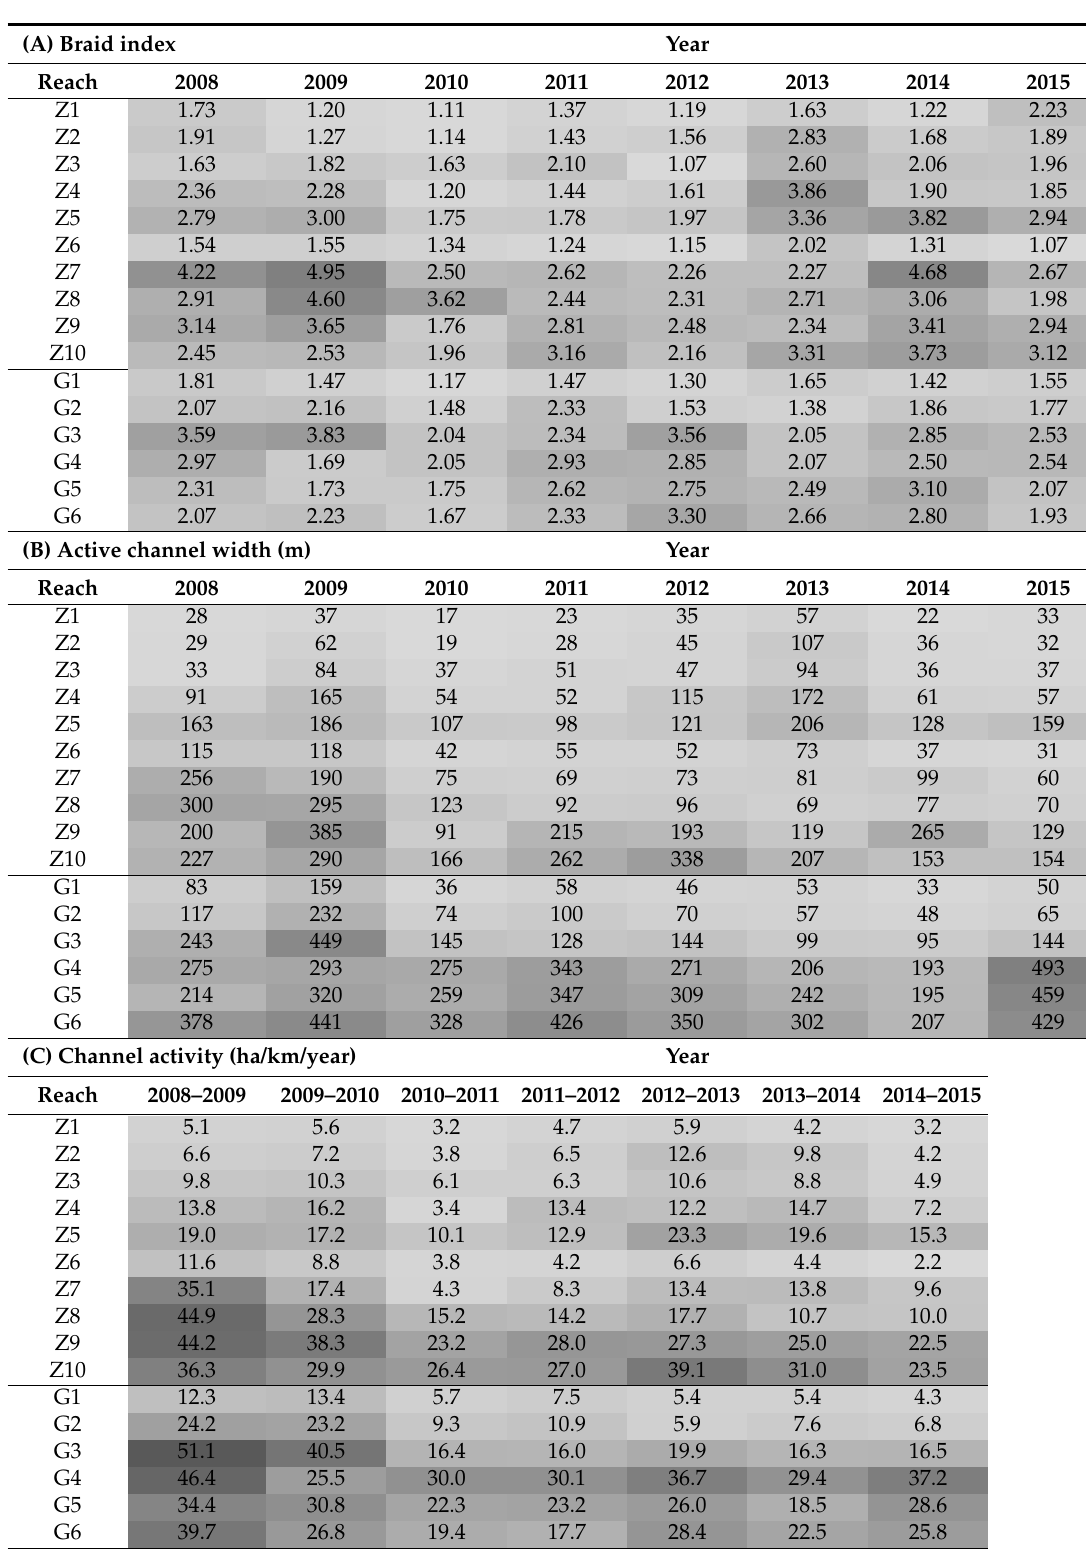
Table 2. Channel planform indices are listed by reaches and years and shown in grayscale. The higher values are shown by the darker